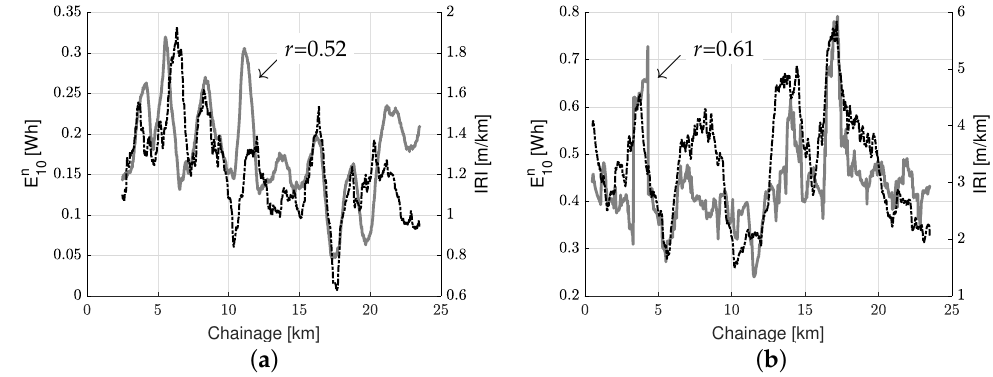
Figure 11. Normalized energy versus road roughness utilizing a 1000-m moving average window: ( a ) energy highway road pass no. 2 and ( b ) urban road pass no